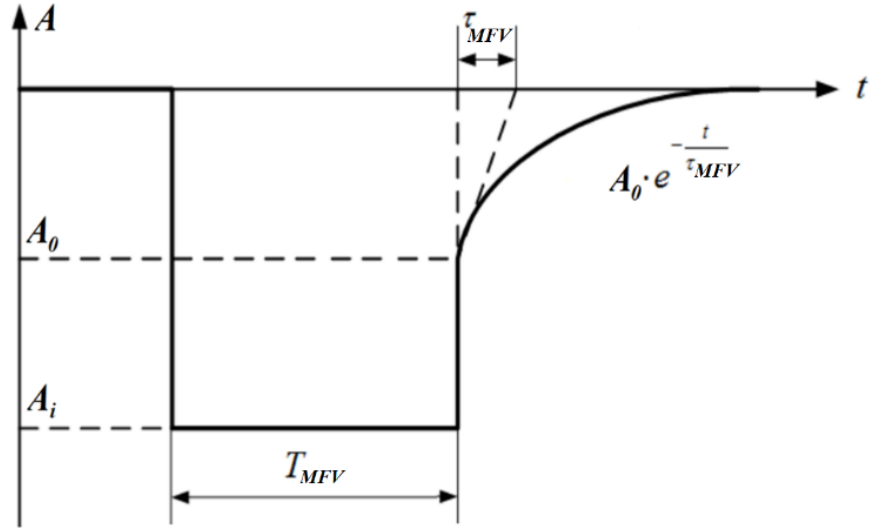
Figure 1. Electrical signal forming the MFV .